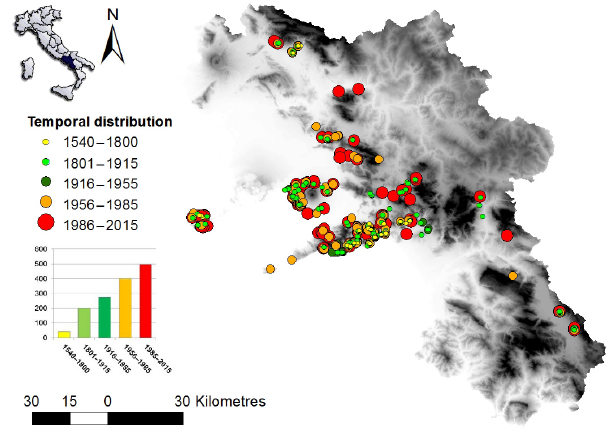
Figure 5. Temporal distribution of alluvial events in Campania. On the left a histogram illustrates their distribution over the time.